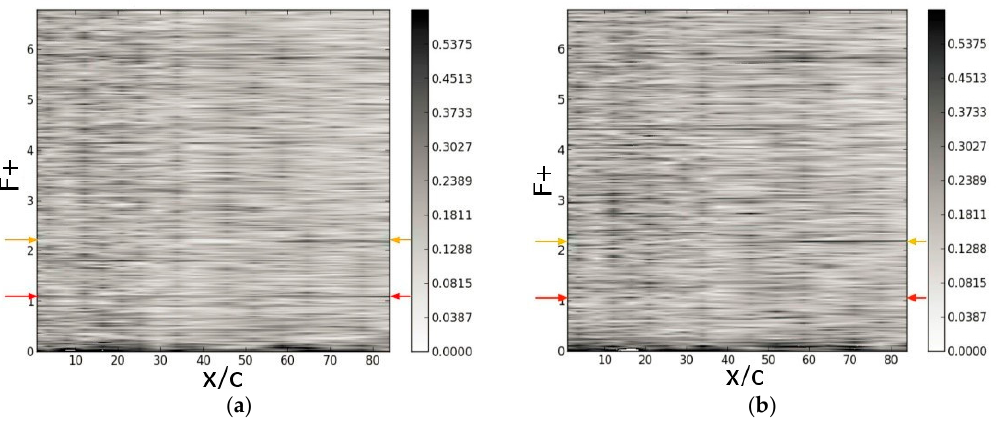
Figure 37. Wing glove wind tunnel measurements for Re = 64,000 and α = 8 degrees. Temporal Fourier transforms of wall pressure coefficient versus chord length. Active flow control with F + = 1.1 and ( a ) B = 0.004 and ( b ) B = 0.1. (Reprinted by permission of the American Institute of Aeronautics and Astronautics, Inc. (Reston, VA, USA) from [37]).